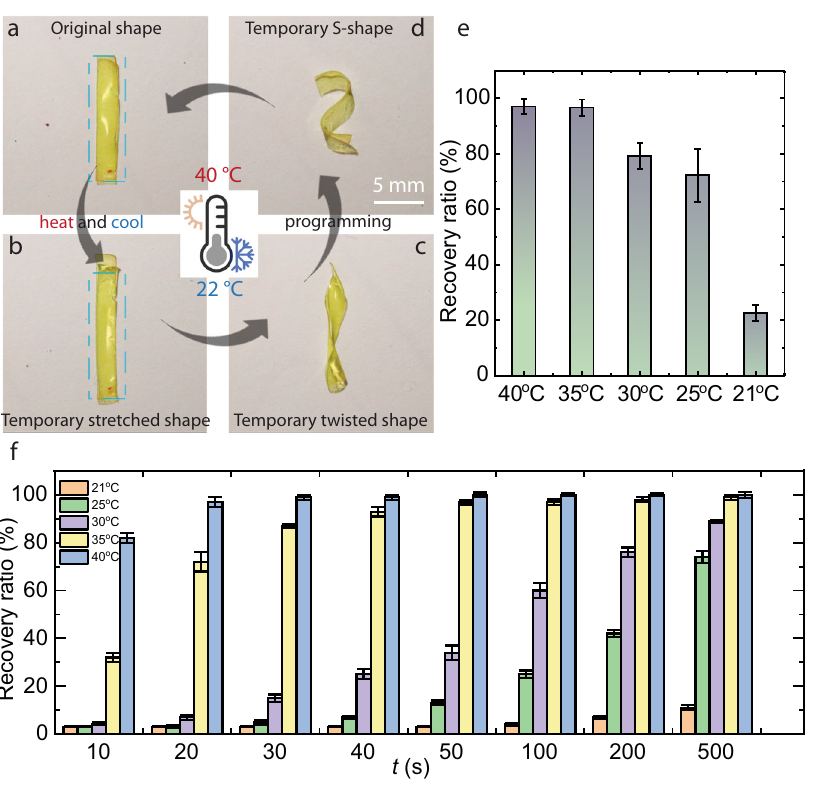
Fig. 4 | Thermo-responsive shape memory effect.a – d Photographs illustrating a shape recovery process of PD 1 (sample dimensions: 20×1.0×0.1mm). e Total shaperecoveryratioatdifferenttemperaturesafter1hand f aplotdepictingshape